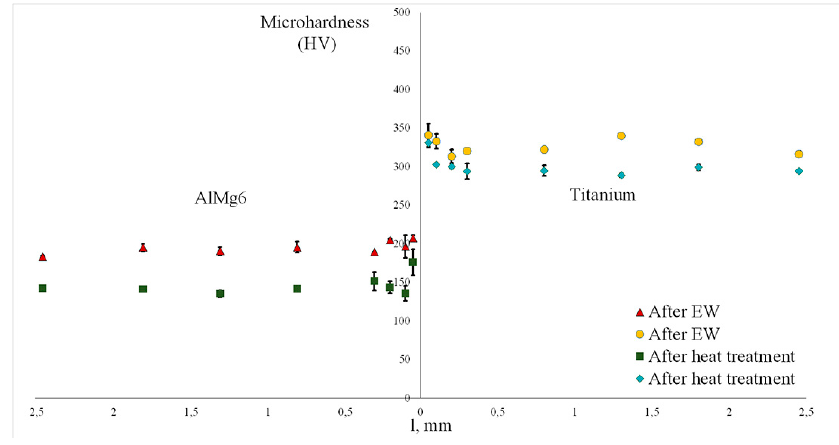
Figure 6. Microhardness of AlMg6–titanium weld interface.